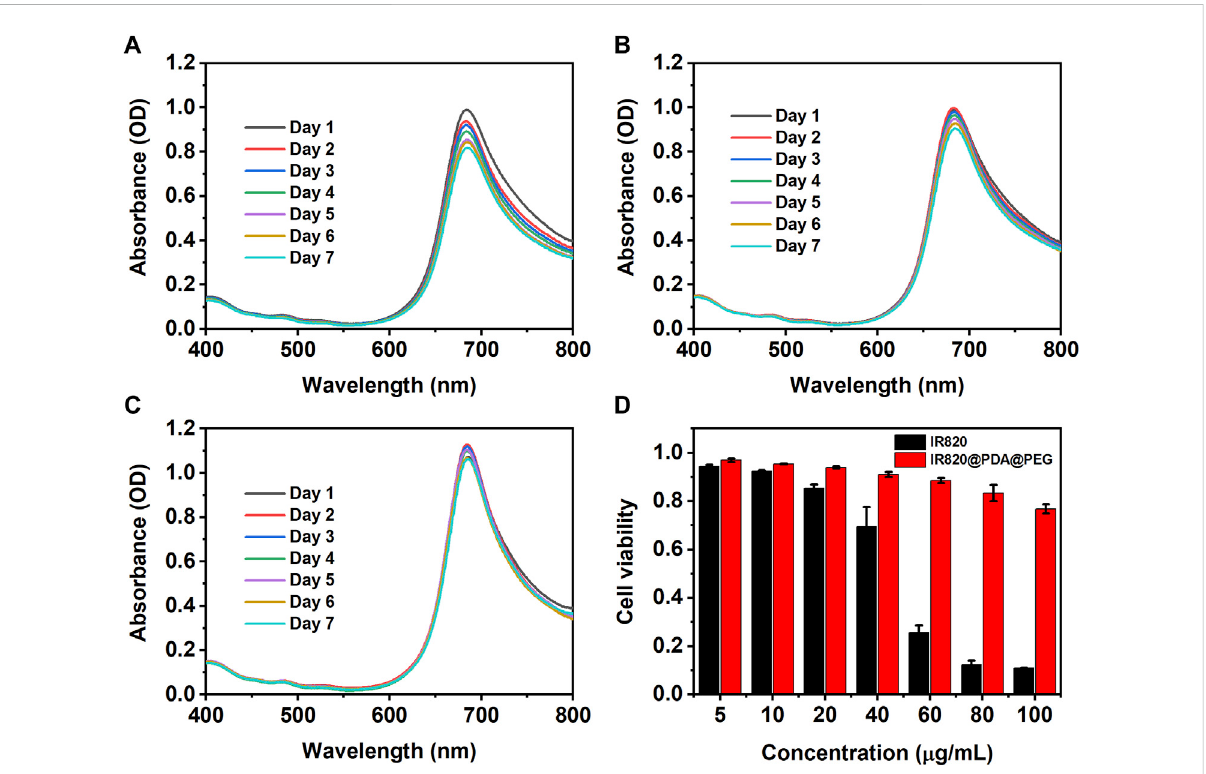
FIGURE 3 The photochemical stability of IR820@PDA@PEG NPs in pH = 5.5 (A) , 6.0 (B) and 7.4. (C) aqueous solutions for 7 days (D) Cytotoxicity of HeLa cells incubated with free IR820 and IR820@PDA@PEG NPs at different concentrations (5, 10, 20, 40, 60, 80, and 100 μ g/ml) for 4 h. Data are expressed as mean S.D. (n = 3 in each